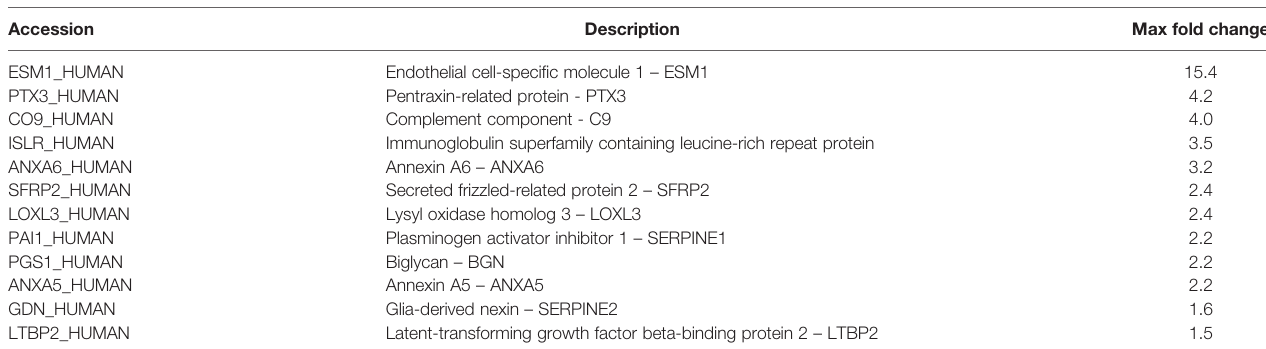
TABLE 5 | Less abundant classically secreted proteins found in ERS